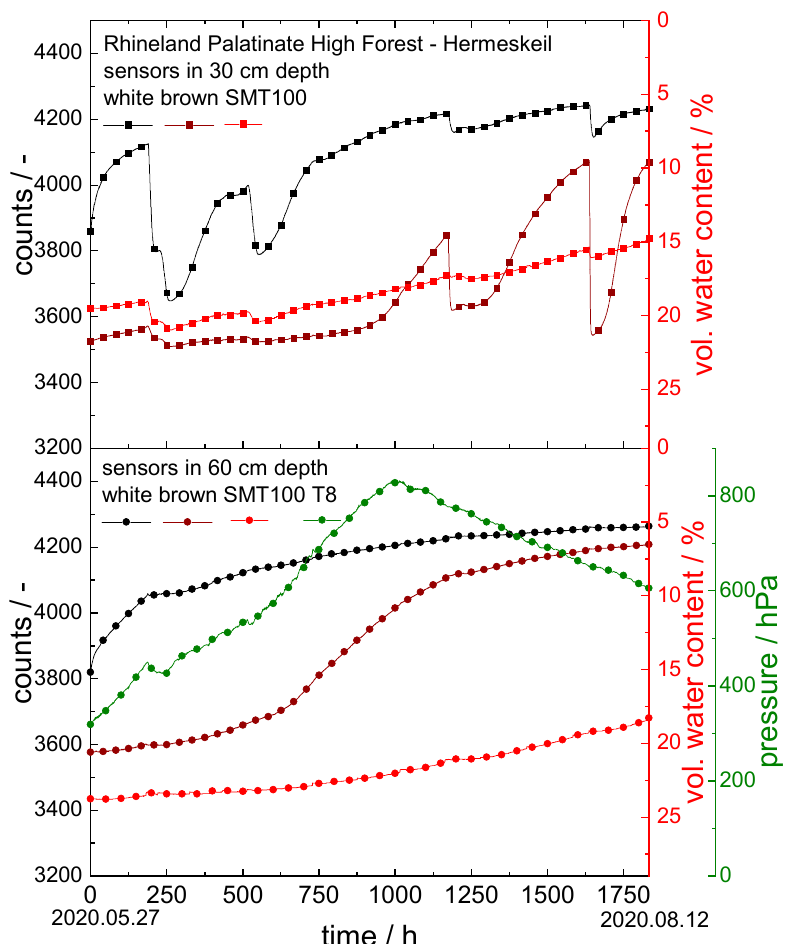
Figure 8. Drying experiment in forest soil (Rhineland Palatinate High Forest: Hermeskeil); counts are plotted vs. time in hours for the sensors with the ceramic discs; vol. water content vs. time for the SMT100 and soil water potential vs. time for the T8 tensiometer. Time = 0 h corresponds to the